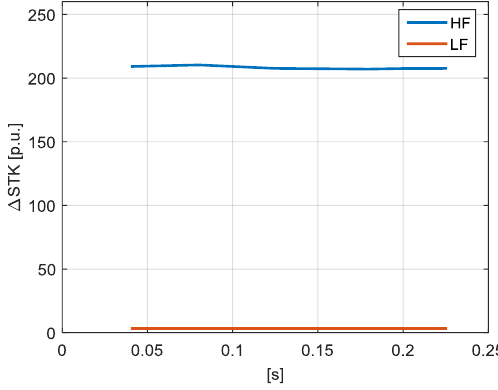
Figure 30. Case study 1: Δ STK at low-frequency (0 ÷ 2 kHz, red line) and at high-frequency (2 ÷ 150 kHz, blue line) obtained through Prony’s method.